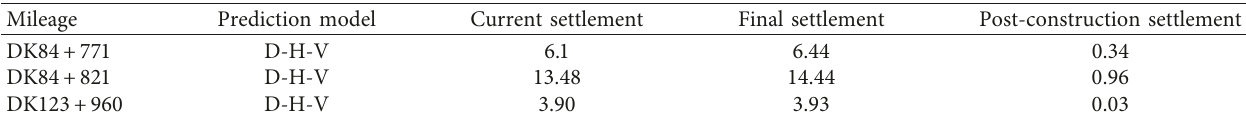
Figure 4: Observation time and residual scatter plots. (a) DK84 +771 section. (b) DK84 +821 section. (c) DK123 +960 section. Table 6: Post-construction settlements